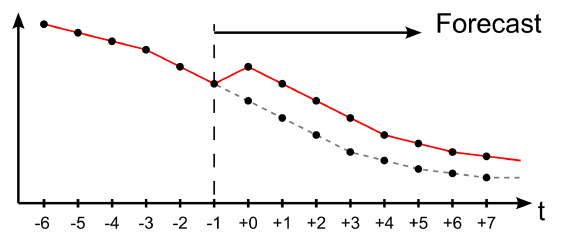
Figure 3. Conceptual example of meteorological forcing for ocean model with hotstart at − 1h.